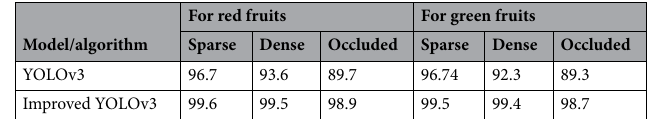
Table 5. Yield estimation accuracy of tomato in special field of